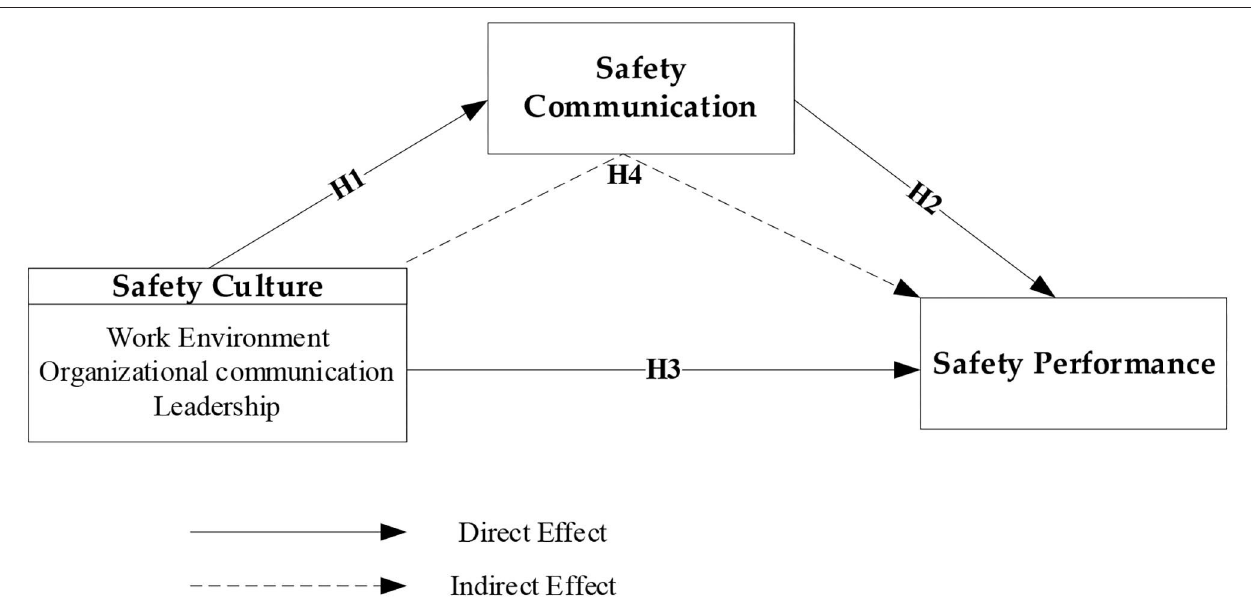
FIGURE 2 | Safety performance hypothesis